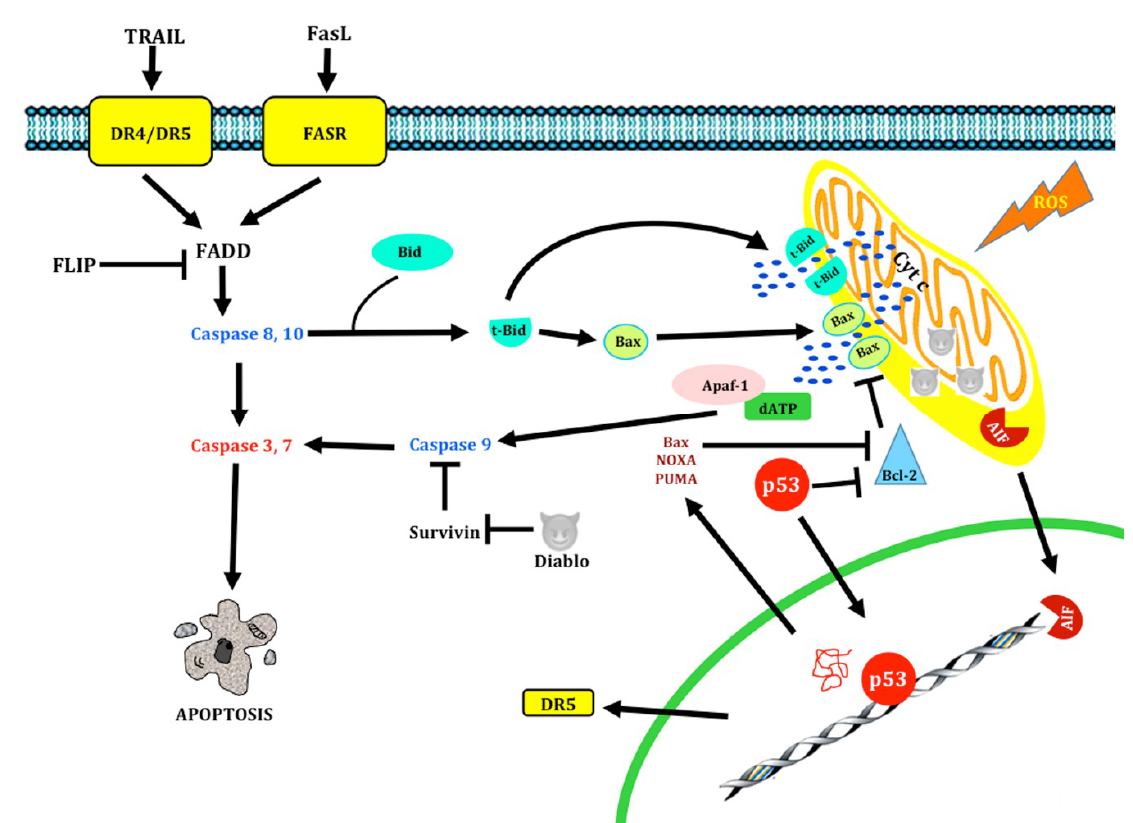
Figure 2. Apoptosis pathways include those initiated by death-receptor ligand or mitochondrial stress (i.e., ROS production). The extrinsic pathway is initiated by the interaction of ligands with death receptors such as TRAIL and Fas. Once activated, they recruit the adaptor protein FADD, which leads to the autoactivation of caspases-8 and -10, which in turn promote the catalytic activation of the effector caspase-3. Another target of caspase-8 is the pro-apoptotic protein Bid, which is hydrolyzed to tBid, inducing Bax oligomerization and mitochondria depolarization with release of cyt c. Along with the activation of caspase-9, these events amplify the apoptotic pathway. The intrinsic pathway involves the permeabilization of the mitochondrial external membrane, which facilitates the cytosolic release of pro-apoptotic proteins such as SMAC/Diablo and cyt c, which are otherwise confined within the intermembrane space. cyt c binds to the Apaf-1 protein, which in turn binds to and activates caspase-9, which is responsible for the activation of the executioners of apoptosis: caspases-3, -6, and -7. On the other hand, SMAC/Diablo inhibits the survivin protein, which binds to and neutralizes caspase-9. Another protein involved in apoptosis regulation is p53, which transcriptionally activates pro-apoptotic genes like Bax, NOXA, and PUMA, directly inhibiting Bcl-2 and favoring apoptosis. Continue arrows ( ↓ ) mean activation, truncated arrows ( ⊥ ) mean